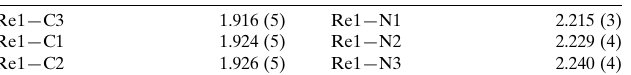
Selected bond lengths (A˚ ).